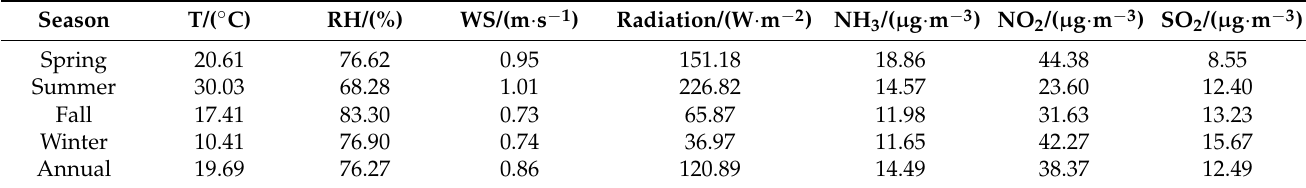
Table 1. Meteorological data and air pollutant concentrations during the sampling